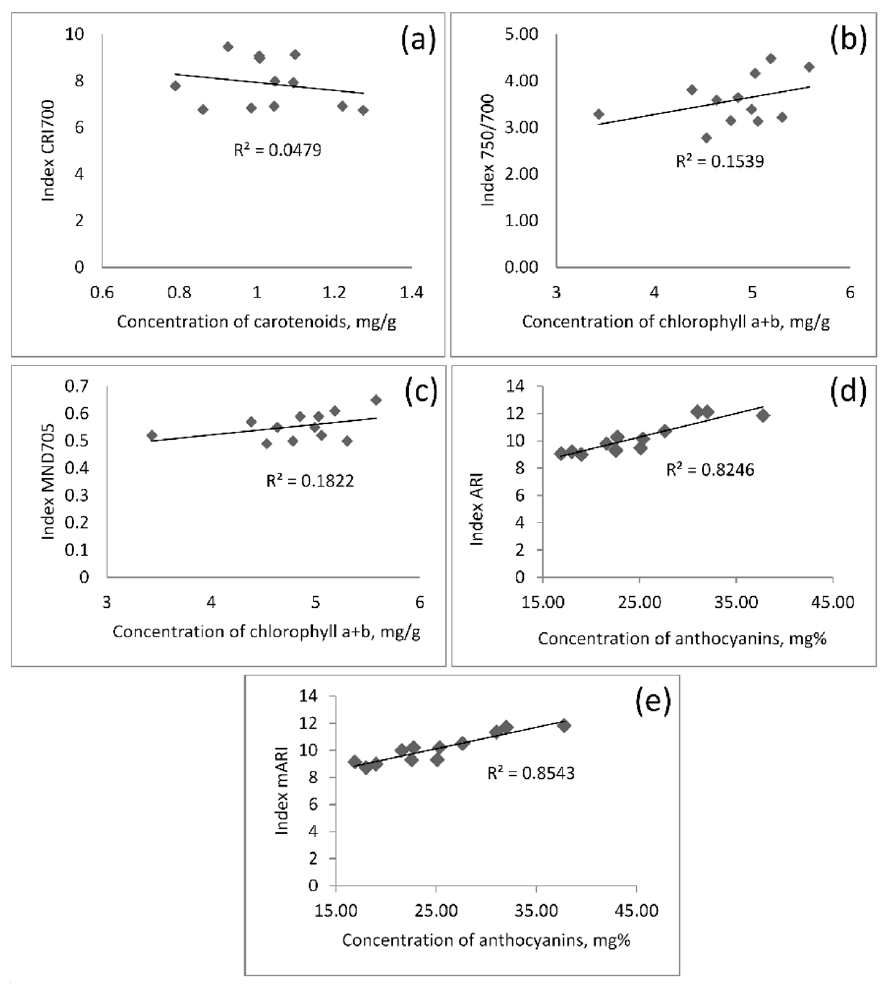
Figure 8. Evaluation of correlation between pigment concentration and vegetation indices obtained on 30th day of cultivation. ( a ) Correlation between CRI 700 index and carotenoids concentration; ( b ) correlation between the R 750 /R 500 index and a+b chlorophylls concentration; ( c ) correlation between MND705 index and a+b chlorophylls concentration; ( d ) correlation between ARI index and anthocyanins concentration; ( e ) correlation between mARI index and anthocyanins concentration. The determination coefficients R2 = 0.82 for ARI and R2 = 0.85 for mARI indicate a